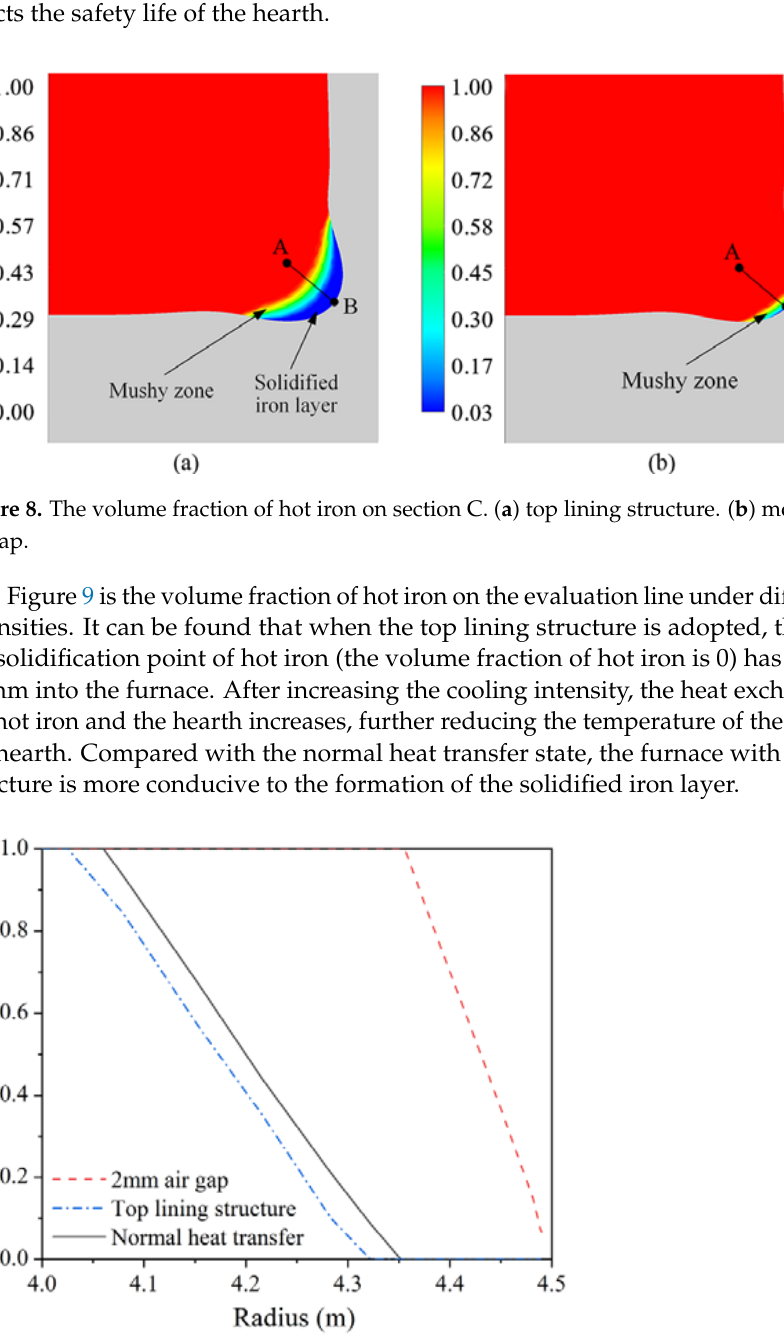
Figure 9. The volume fraction of hot iron on the evaluation line at different cooling intensities.